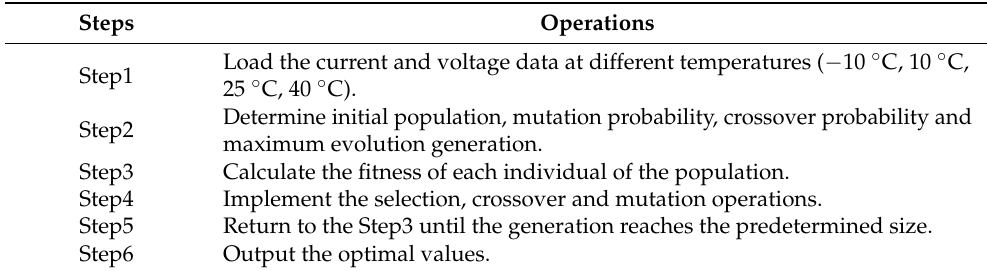
Table 2. The identification process of Thevenin model at different